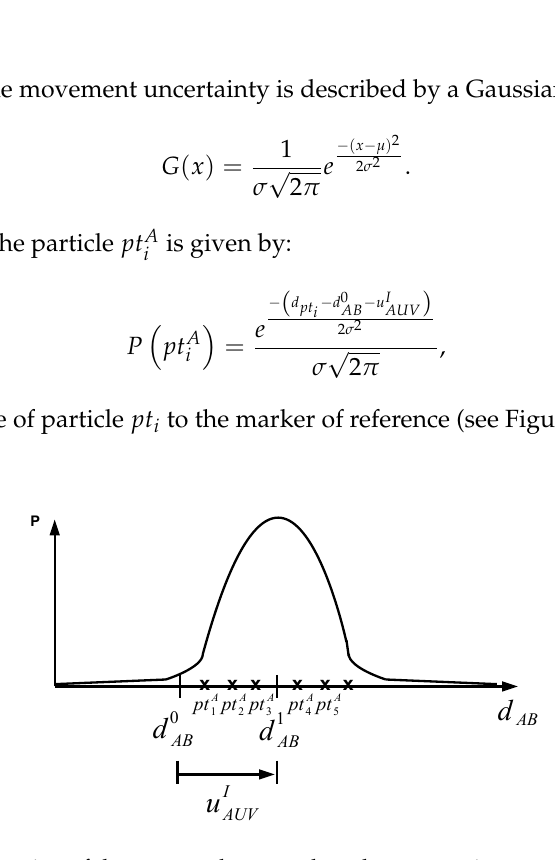
Figure 9. Illustration of the proposed approach to the geometric constraint in the